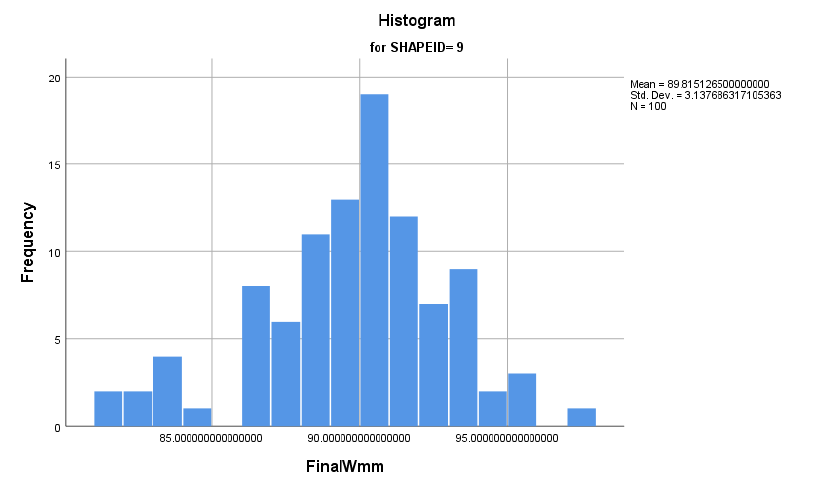
Figure A19. Shrink width adjustment for 90 mm.